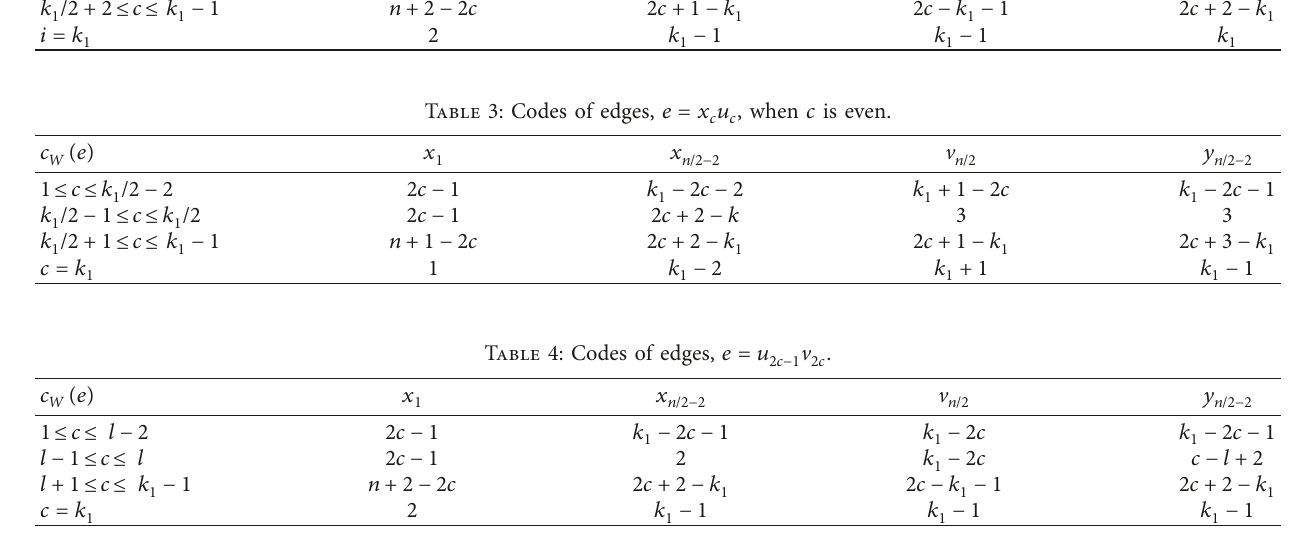
Table 2: Codes of edges, e � x